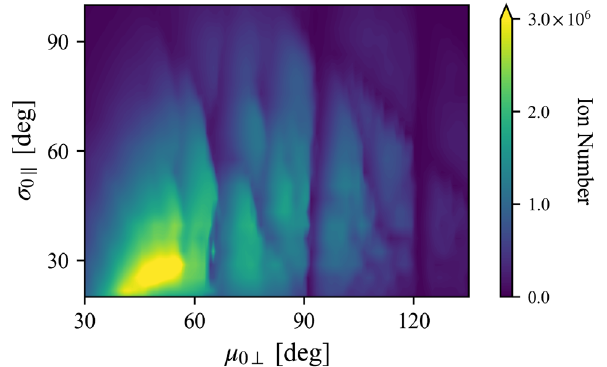
FIG. 3. Number of confineable ions with the betatron and synchrotron phase advances fixed through the whole experiment process from the ion production to the extraction. The map contains 6000 independent data points. The final ion number at each operating point was measured after the routine ionization procedure of 1 s long, followed by 51.2-ms storage.